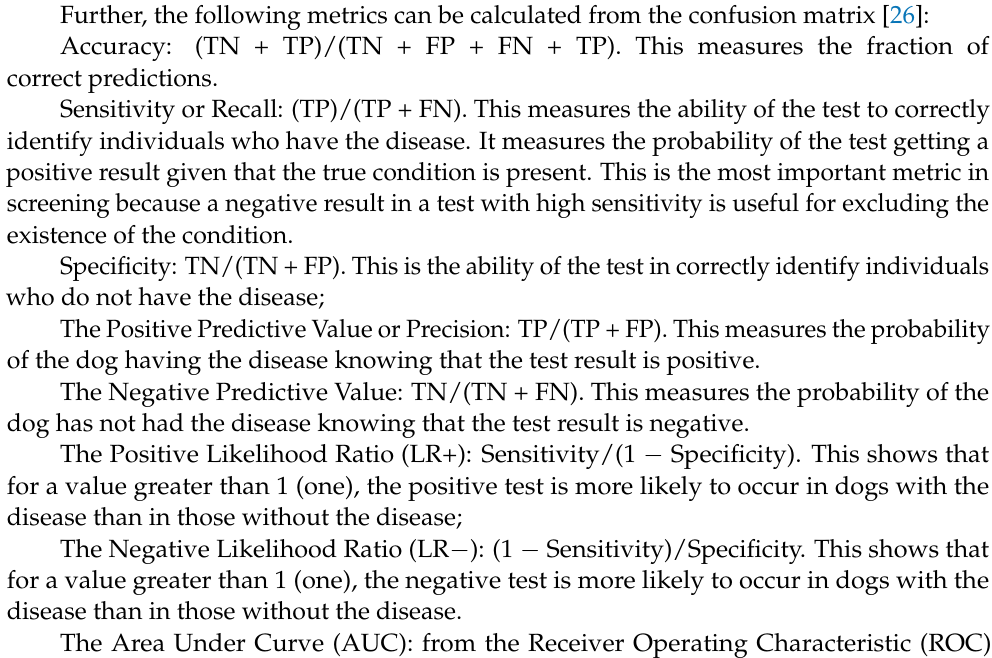
Table 2. Indications of the confusion matrix. Predicted as Negative Predicted as Positive Labeled as Negative True Negative (TN) False Positive (FP) Labeled as Positive False Negative (FN) True Positive